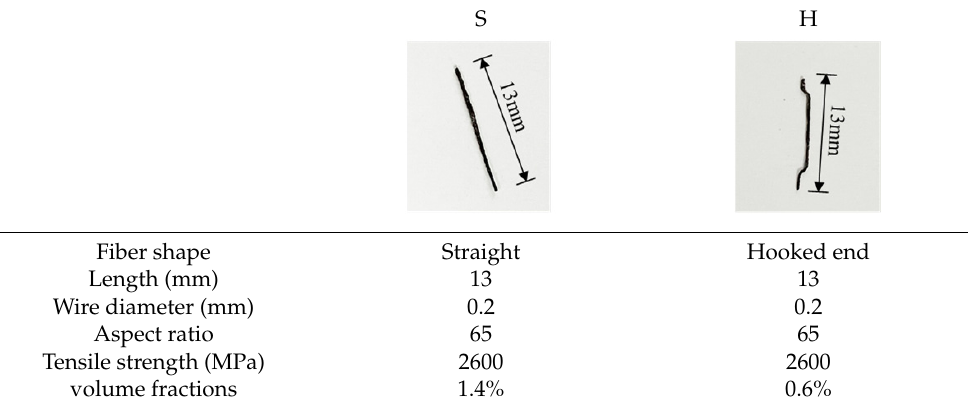
Table 2. Properties of the steel fibers used in the UHPC